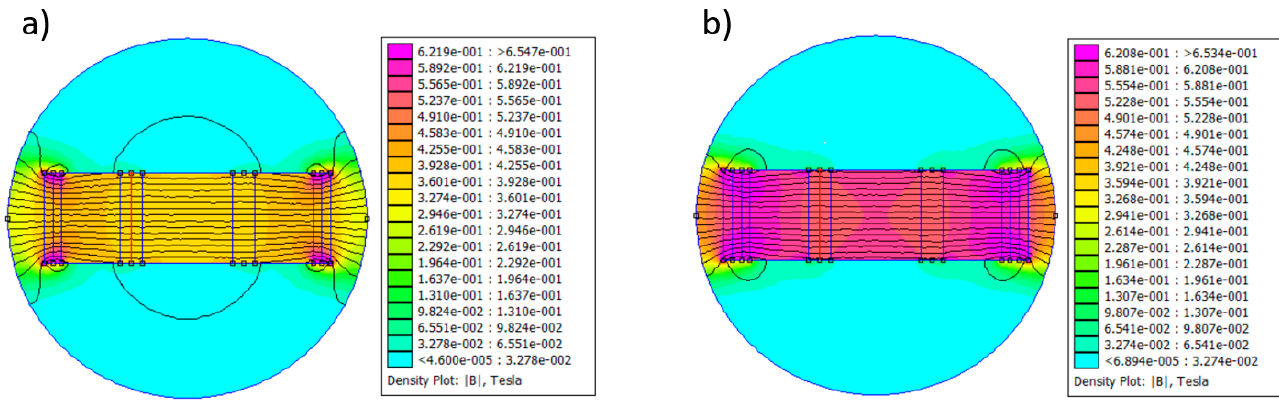
Figure A1. Calculated magnetic field intensity using ( a ) 2 pairs of permanent magnets and ( b ) 3 pairs of permanent magnets.